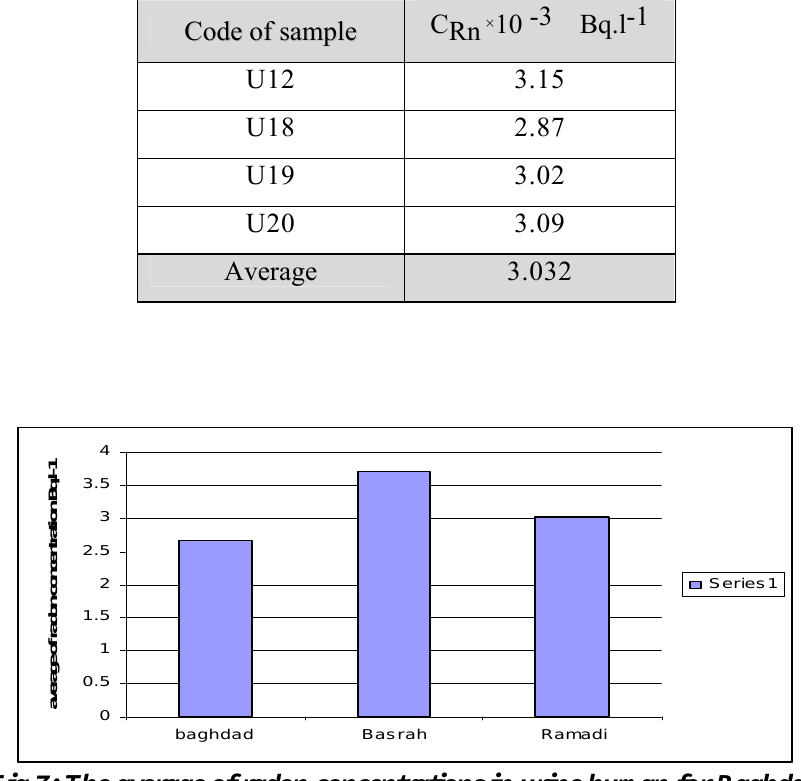
Table 7: Radon concentration in urine human of Ramadi samples